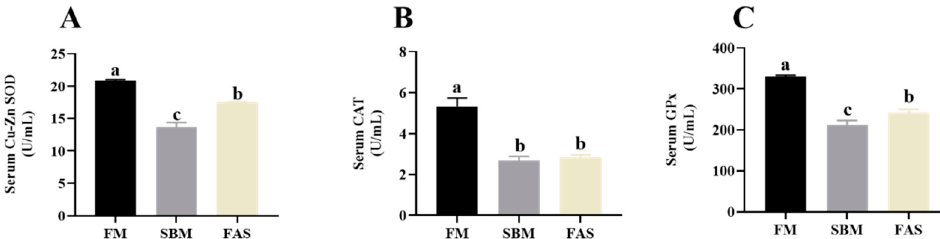
Figure 3. Immune responses of Japanese seabass fed diets using soybean meal as fishmeal alternative with or without functional additives. ( A ) Respiratory burst activity of the head kidney macrophages. ( B ) Serum alternative complement pathway (ACP) activity. Data are presented as means ± SEM. Bars sharing the same letters are not significantly different ( p > 0.05, n = 12).